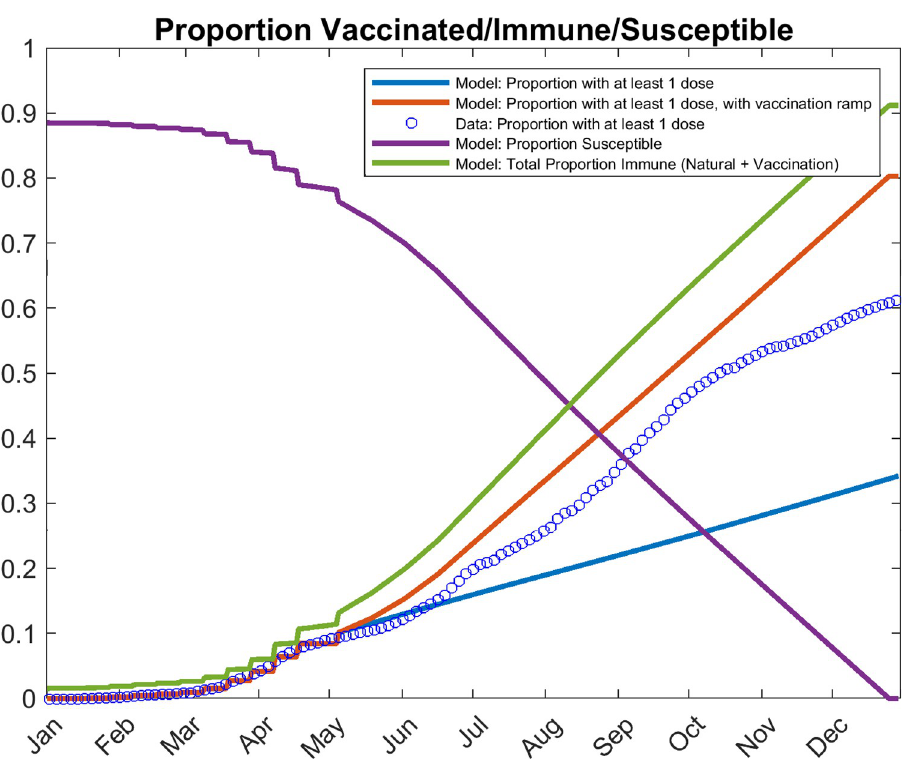
Fig 1. Median model predictions of proportions vaccinated, susceptible, and immune plotted against reported vaccination data. Data (open blue circles) are shown every 3 days for clarity. The median model prediction of the proportion of the population with at least one dose of vaccine is given by the blue line. If a biweekly ramp in vaccination ramp is applied after May 5 th , the proportion with one dose is given by the red line. The median model predictions of the proportion susceptible and total immune are given by the purple and green curves, respectively. As of May 5 th , 2021, approximately 9% of India’s population had received at least one dose of vaccine, while only a total of 13% had acquired immunity to the